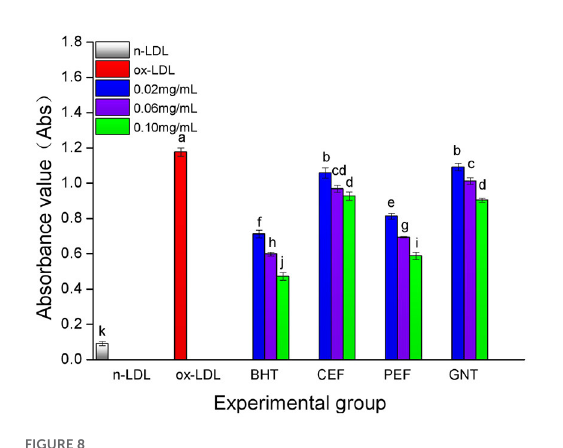
FIGURE8 The CD generative effect of CEF, PEF and GNT at different concentrations. Different lowercase letters indicate significant differences between each individual experimental group ( p < 0.05).